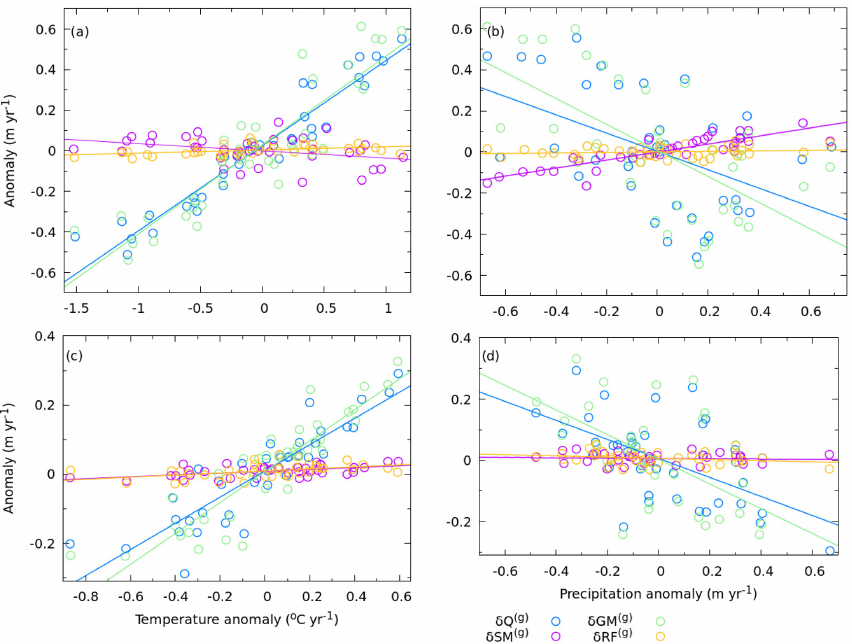
Figure 7. The anomalies of glacier runoff δQ ( g ) and its components, namely snowmelt δ SM ( g ) , glacier ice melt δ GM ( g ) , and rainfall δ RF ( g ) for the glacierised parts of the catchments are plotted as a function of the corresponding temperature and precipitation anomalies: (a, b) for the Chandra catchment and (c, d) for the upper Dudhkoshi catchment. The corresponding best-fit straight lines are also